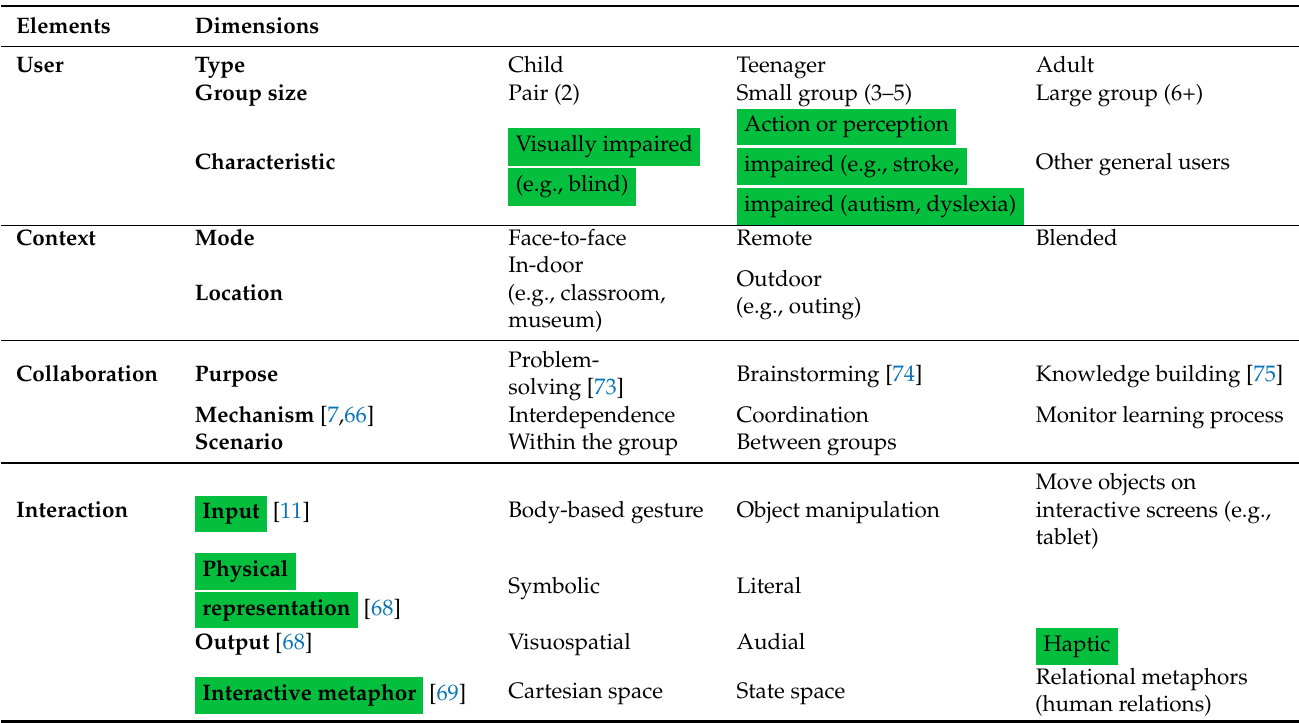
Table 1. Design space for tangible collaborative learning (unique tangible designs are indicated with green color